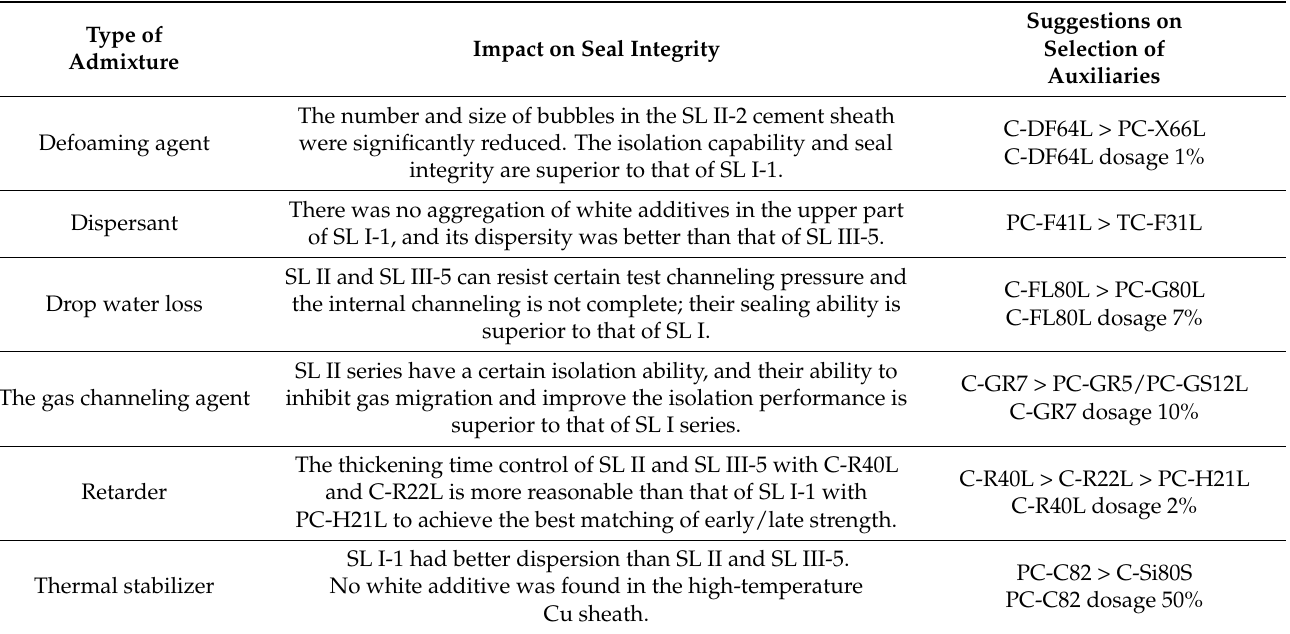
Table 3. Five cement sheath seal integrity test